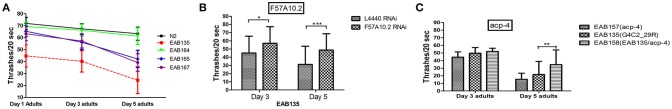
Suppressor genes F57A10.2 and acp-4 may exert their effects on C9ORF72 associated pathology via a loss-of-function mechanism. (A) EAB164, EAB165, and EAB167 were identified as suppressors of the slow movement phenotype of EAB135. All three suppressors were associated with improved swimming activity in thrashing assays using Day 1, Day 3, and Day 5 adults, compared to EAB135 animals. Strain EAB164 was the most significantly improved suppressor strain, showing almost similar movement ability to N2 animals. (B) Downregulation of suppressor gene F57A10.2 in EAB135 animals, by feeding RNAi, produced improved movement in swimming assays, with swimming resembling activity in strains carrying the potential relative null alleles. Total numbers of 50–98 animals were used in each condition. Three experiments were performed in each case. *P < 0.05, **P < 0.0002, ***P < 0.00001. (C) We constructed EAB158 carrying acp-4 (lf,gk833833) on EAB135 background. EAB158 animals moved significantly better than both EAB135 and EAB157 (gk833833). Total numbers of 75–98 animals were used in each condition. Three experiments were performed at room temperature in each case. **P < 0.0002.